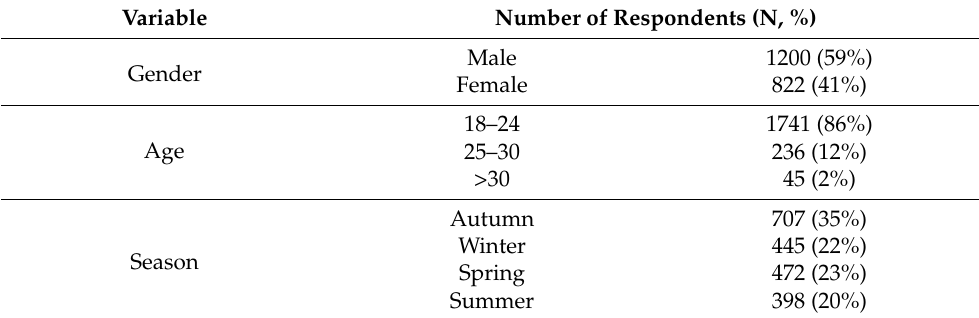
Table 1. Participants’ characteristics.